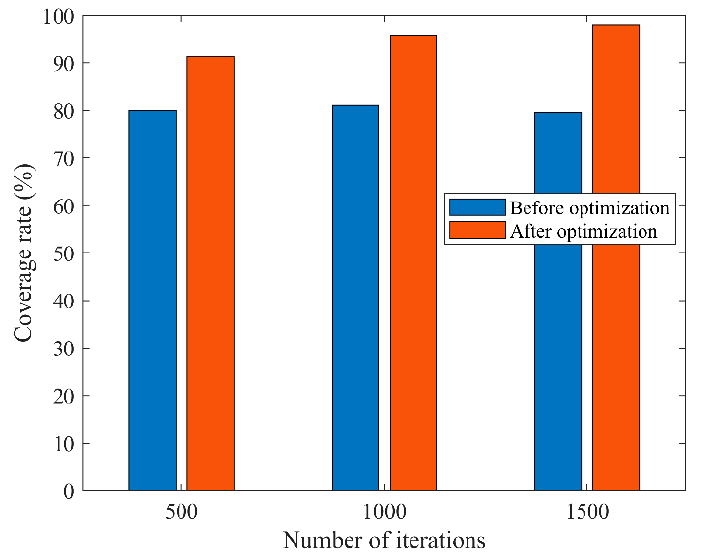
Figure 18. Comparison of coverage rates before and after optimization by COOTCLCO when the number of nodes is 45.